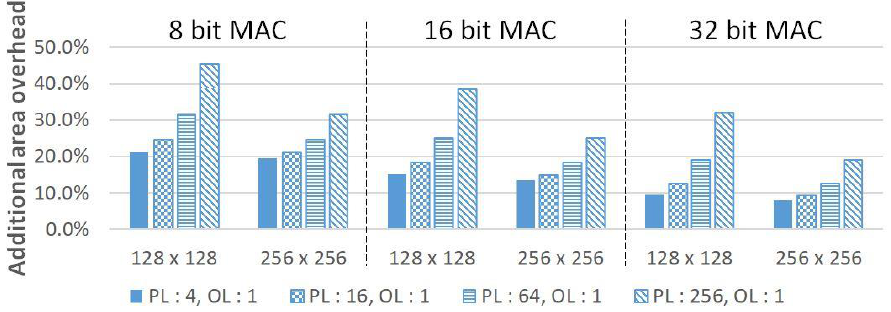
Figure 12. Hardware overhead comparison for various PL s.